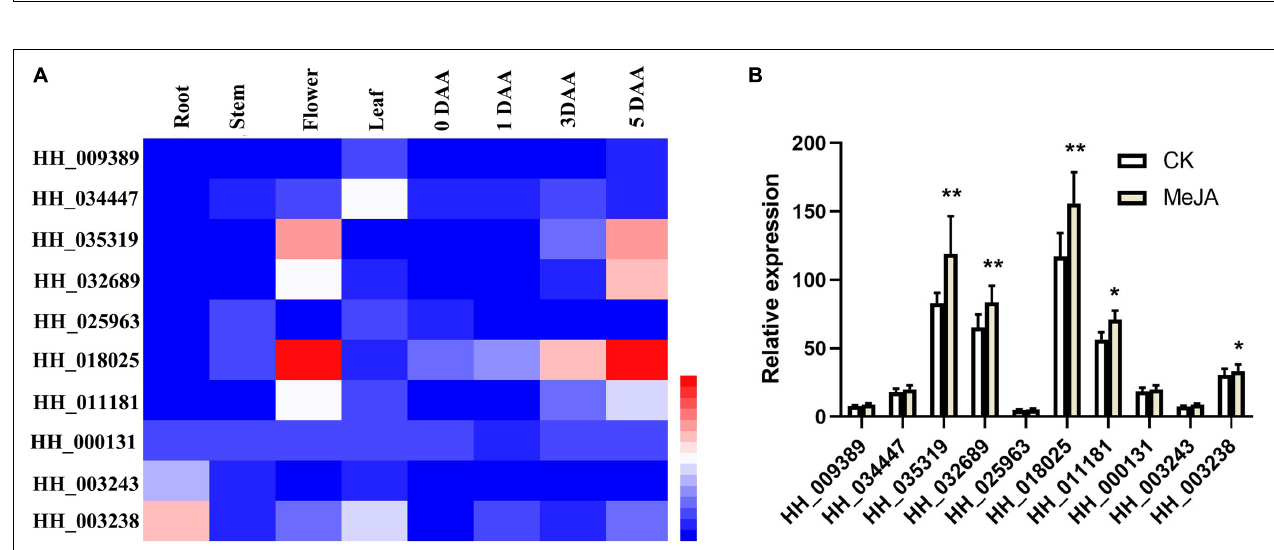
FIGURE 7 | Quantitative analysis of the candidate genes of C-glucosylquinochalcones biosynthesis. (A) The heatmap of the expression of candidate genes, based on the different tissues and different stages of flower development. (B) The bar graph of the candidate genes after the treatment with MeJA. ** P = 0.01, * P = 0.05.